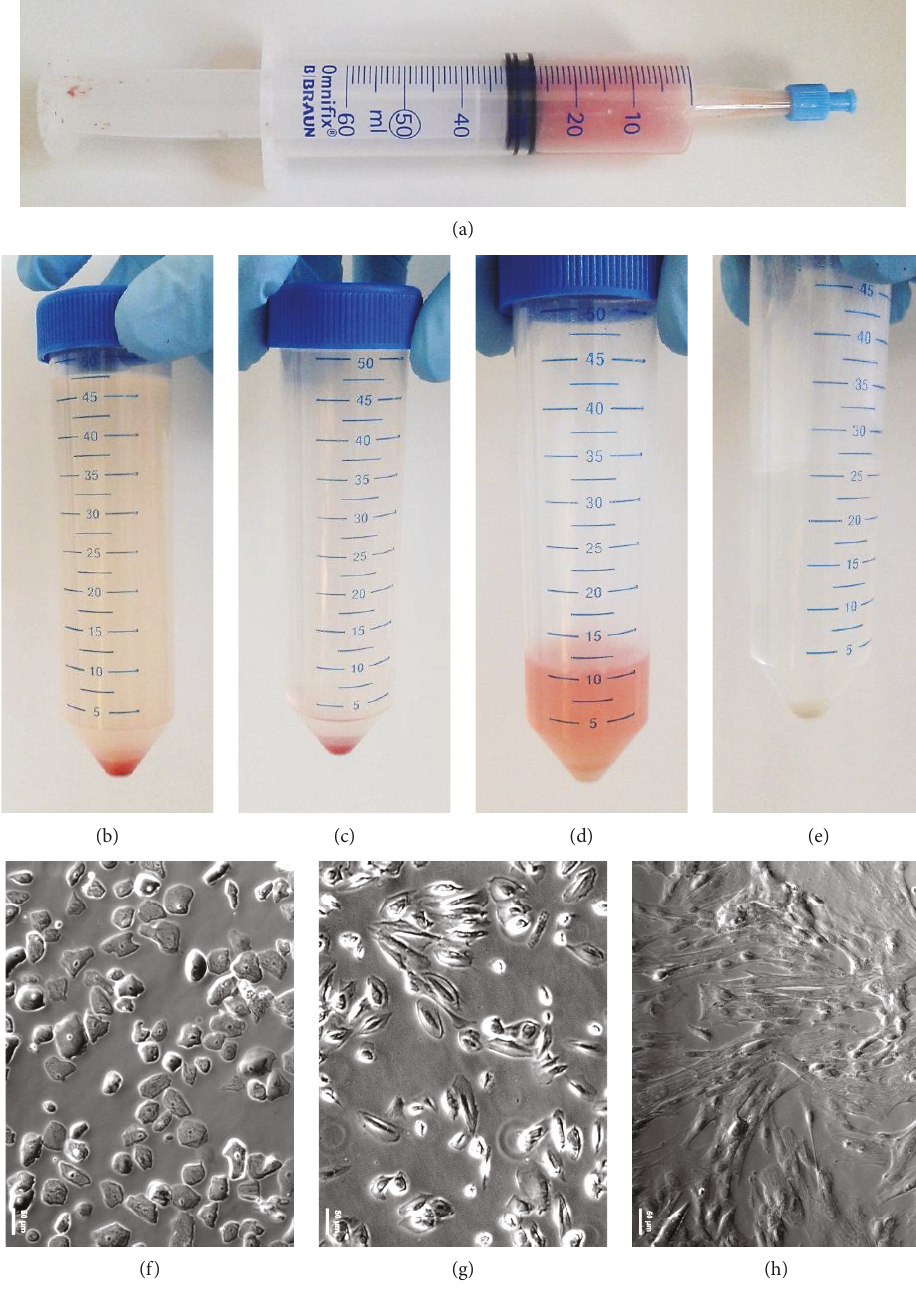
Figure 1: Amniotic fl uidcellpreparation.Amniotic fl uidwascollectedduringCaesareansectionsusing a60mlsyringe(a).TheAFwaswashed with PBS and centrifuged resulting in a reddish pellet (b, c). The red colour indicated the presence of erythrocytes which were then lysed using ammonium chloride at 4 ° C. The resulting white cell pellet (d, e) was transferred to cell culture vessels showing high level of heterogeneity (f). After, prolonged in vitro culture and passaging heterogeneous cell morphology (g) became uniform showing spindle-shaped fi broblast-like morphology